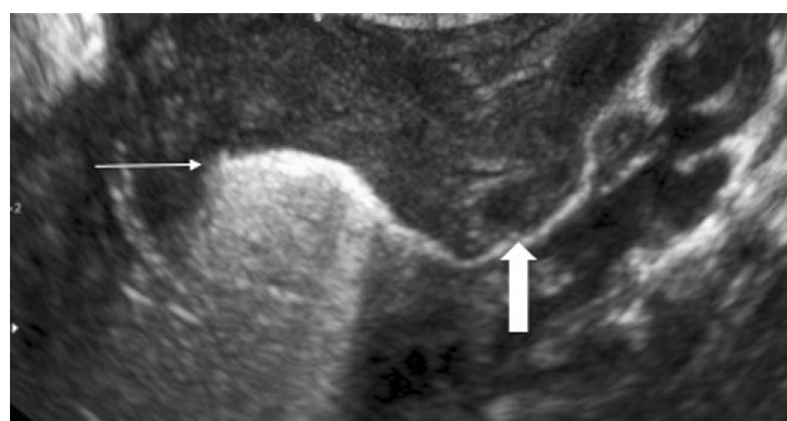
Fig. 1 CEUS hysterosalpingogram. Transvaginal ultrasound following intrauterine administration of the ultrasound contrast agent. Contrast fills the endometrial cavity (thin arrow) and unobstructed flow is seen along the left fallopian tube confirming patency (thick arrow). (Image courtesy of Dr. Luca